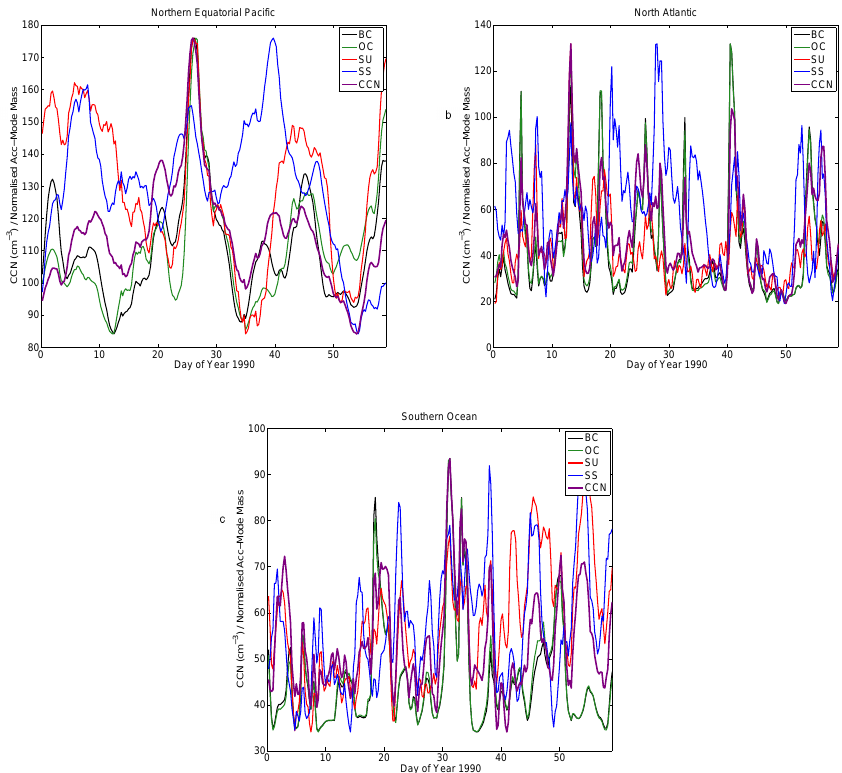
Figure 5. A time series of scaled accumulation-mode mass of black carbon (black line), organic carbon (green line), sea spray (blue line), and sulfate (red line), overlaid with time series of CCN concentrations (purple line) in the three regions being examined.